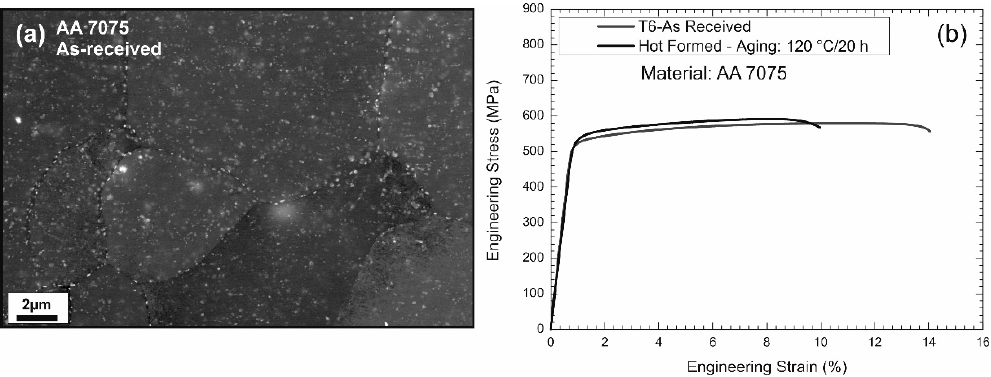
Figure 3. ( a ) Backscattered electron (BSE) micrographs of the investigated material under the T6 as-received condition before thermo-mechanical processing. ( b ) Stress–strain behavior of the formed parts using the novel forming process compared to the as-received condition.